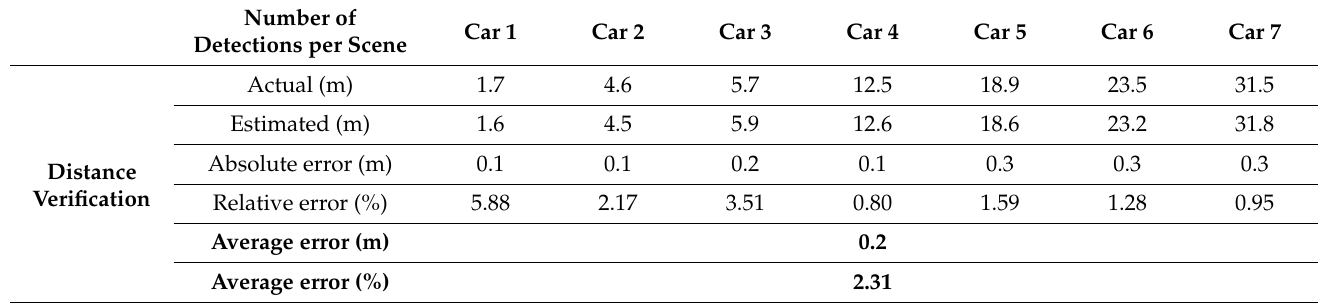
Table 3 . Error metric and accuracy comparison of the quantitative performance of the proposed methodology with those of the existing techniques on the KITTI dataset.